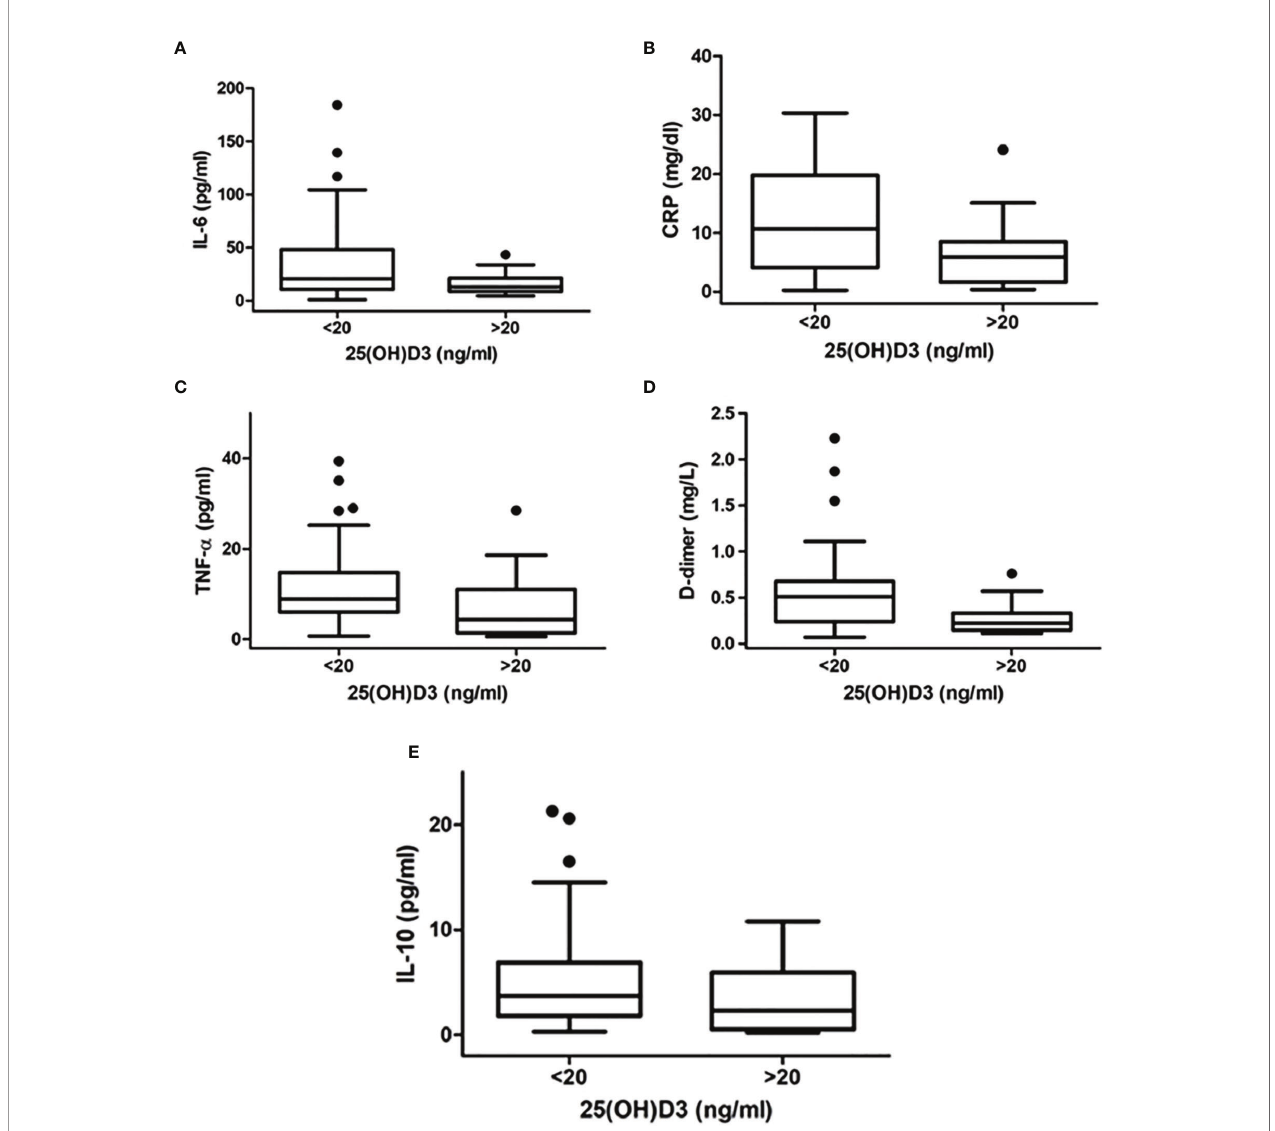
FIGURE 2 | Correlation between in fl ammatory markers [ (A) IL-6, (B) CRP, (C) TNF-alpha, (D) D-dimer, (E) IL-10] and 25OHD levels in patients with